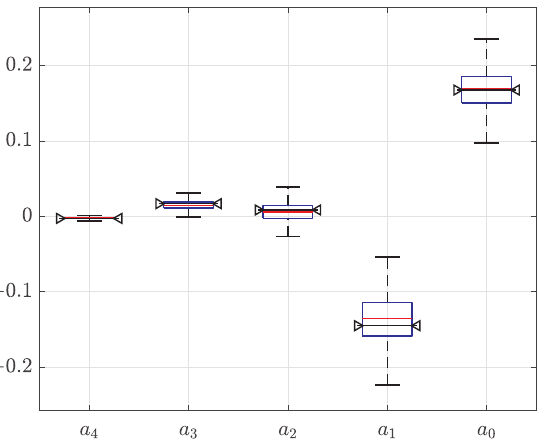
Figure 5. The box plots of estimated coefficients of the polynomial PDF (66) from only 50 samples, and repeated 1000 times. The triangles on the side of the boxes indicate the true coefficient values.